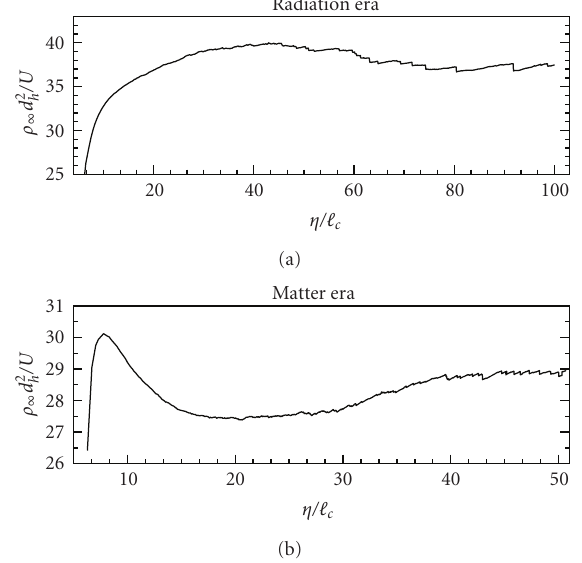
Figure 7: Energy density of super-horizon sized strings as a function of the conformal time (in unit of (cid:15) c ) in the radiation and matter era. After some relaxation time, ρ ∞ ∝ 1 /d 2 proportionality factor is